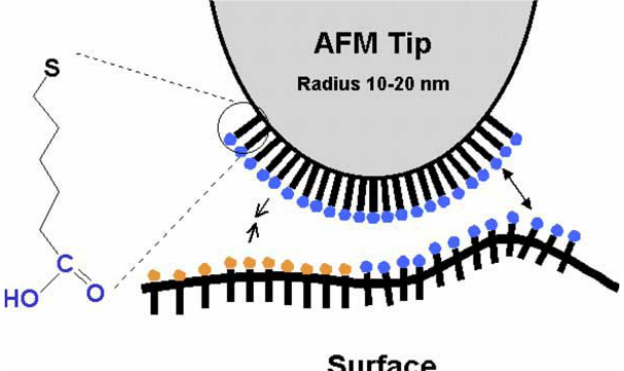
Figure 1. CFM principle: chemical tip modification with SAMs (Reprinted with permission